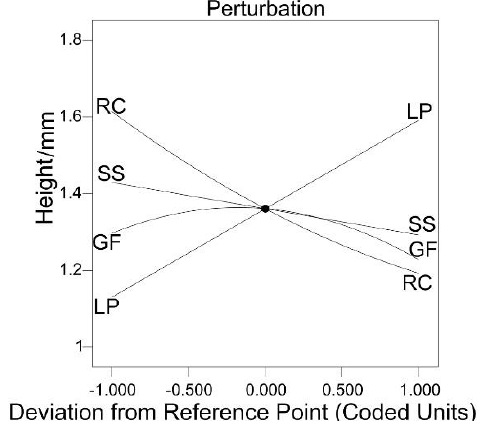
Figure 12. The influence of selected factors on clad width.